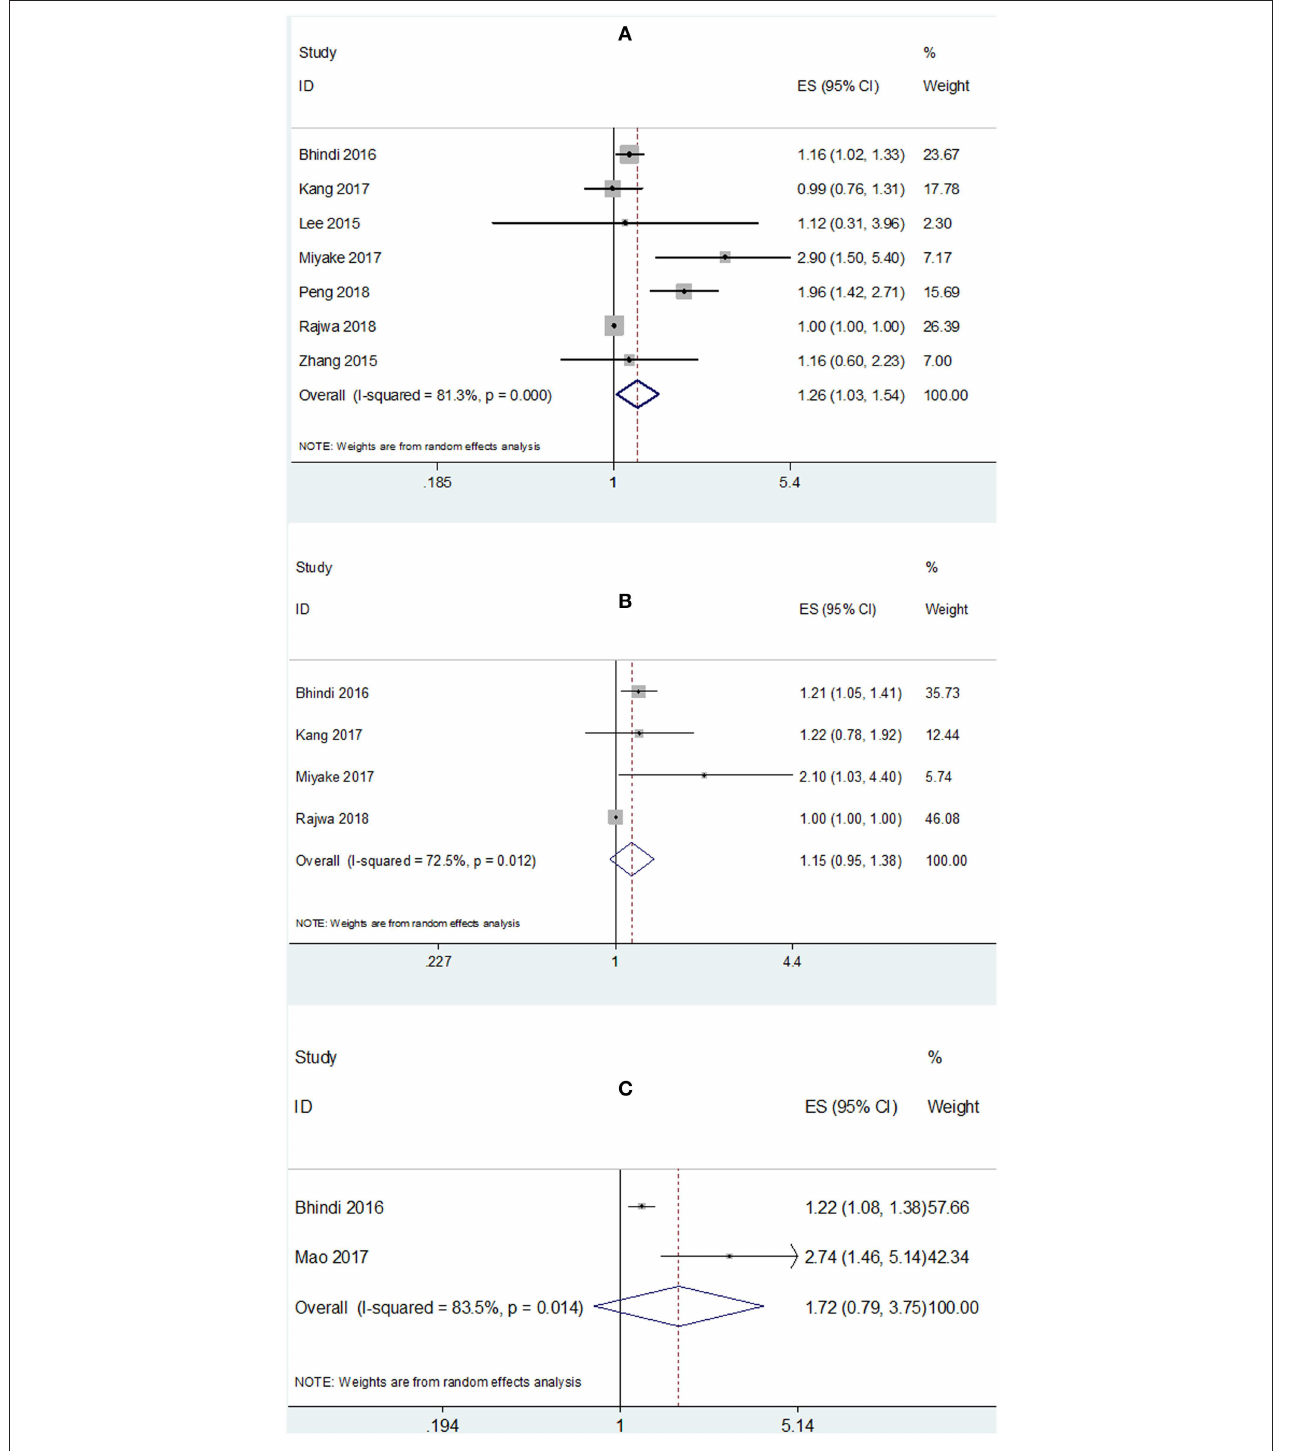
FIGURE 2 | Meta-analysis of the association between PLR and (A) OS, (B) CSS, and (C) RFS mortality of bladder cancer.